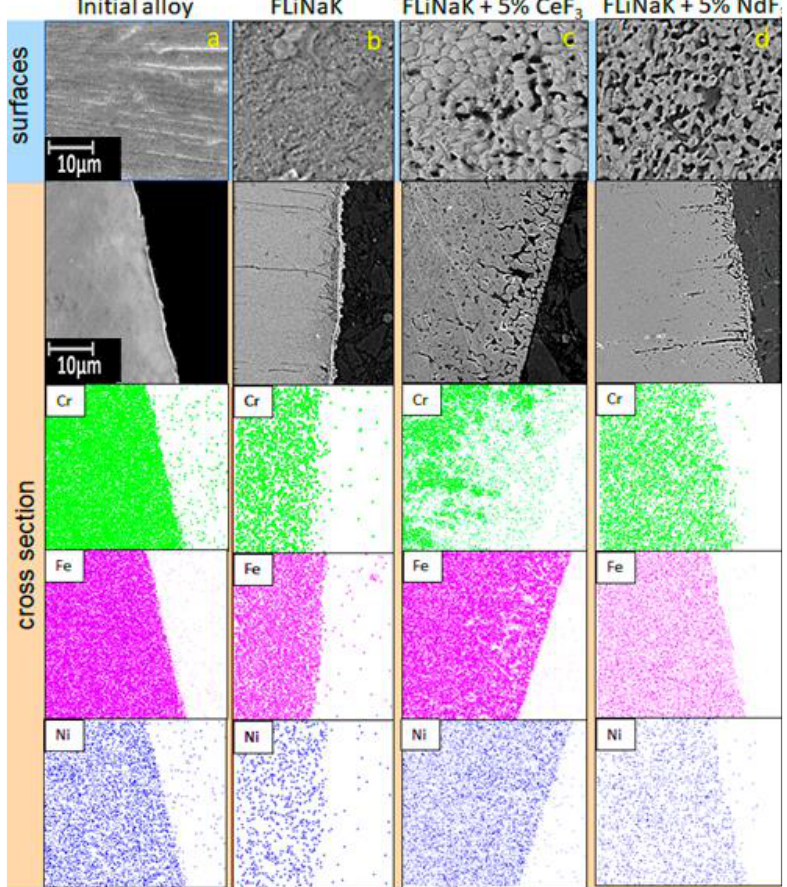
Figure 6. Structure of the surface layers of the 12Cr18Ni10Ti samples after long-term corrosion tests: ( a ) initial; ( b ) exposed in FLiNaK; ( c ) exposed in the FLiNaK + 5 wt.% CeF 3 melt; ( d ) exposed in the FLiNaK + 5 wt.% NdF 3 melt.